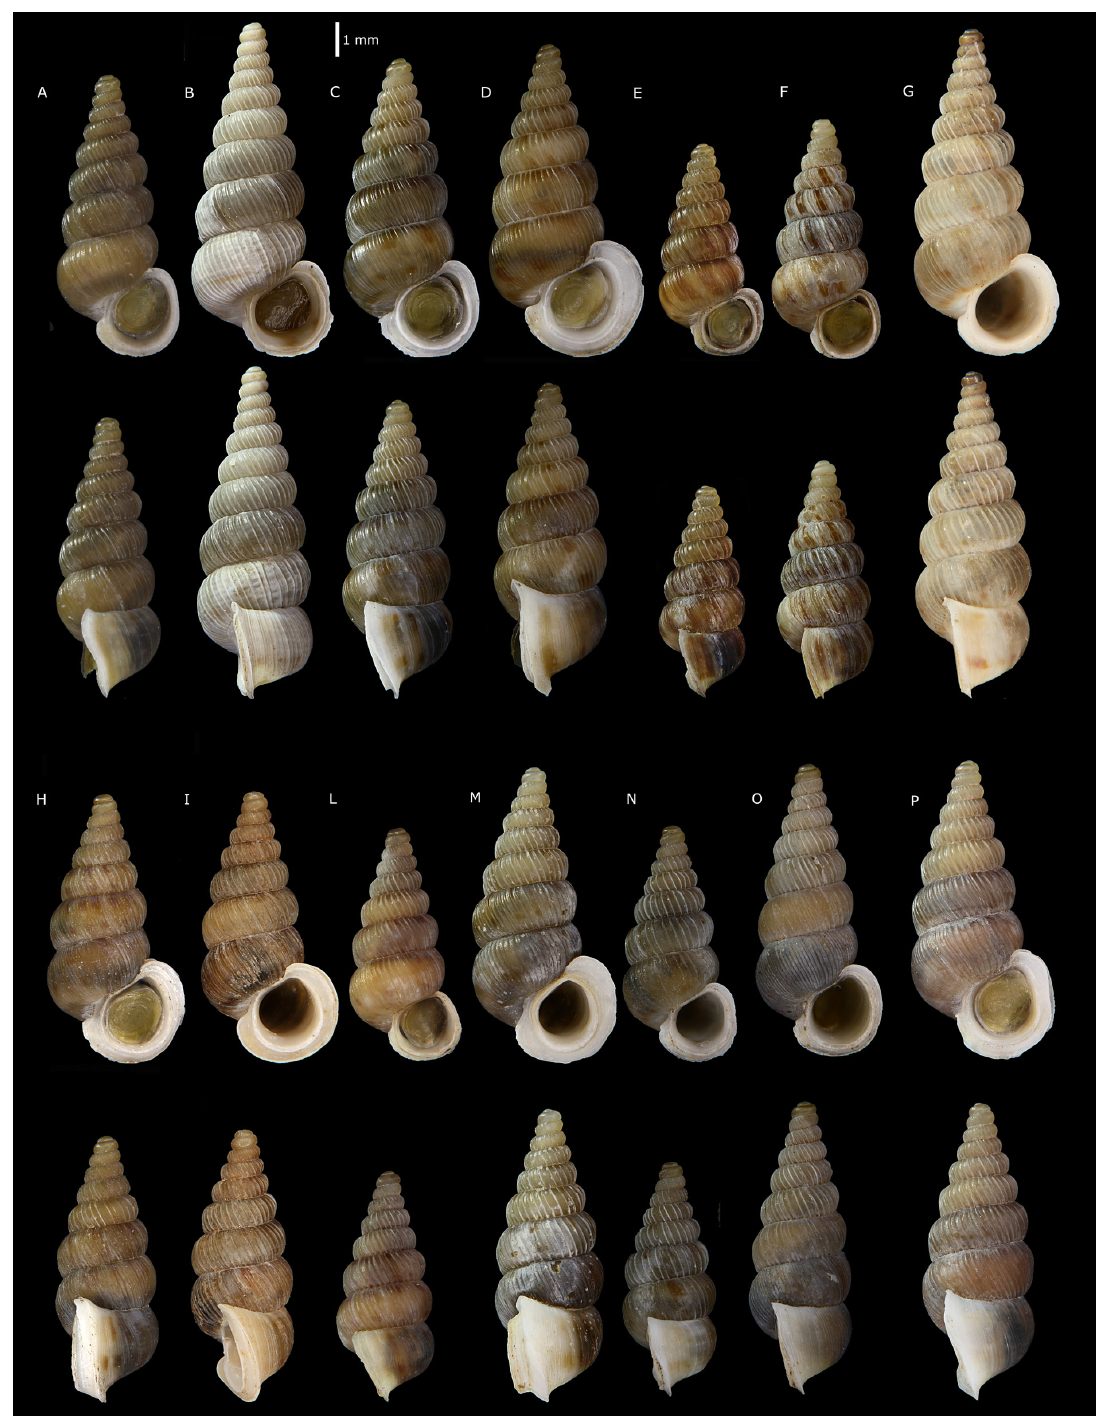
Fig. 28. Shell variability in Cochlostoma ( Clessiniella ) tergestinum (Westerlund, 1878). A . Mt Kobilica, Slovenia (WdM6849). B . Limski Kanal, Croatia (WdM6693). C . Dobratsch, Austria (EZ0799). D . Farjev Vrh, Slovenia (WdM6740). E . Rasko Polje, Croatia (EZ0813). F . Raša, Croatia (WdM6968). G . Val Rosandra, Italy (EZ840). H . Mala Učka, top, Croatia (WdM6794). I . Ilirska Bistrika,